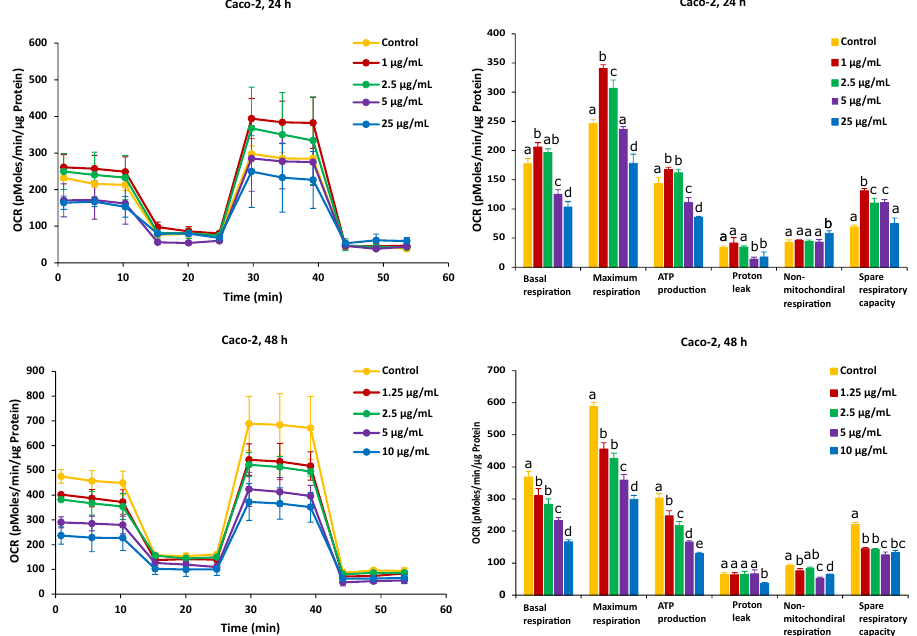
Figure 4. Effect of AFB1 on oxygen consumption rate (OCR) ( left ) and different mitochondrial parameters ( right ) in Caco-2 cells after 24 h and 48 h of exposure. Data (at least four technical replicates) are expressed as mean ± standard deviation. Mean values with different letters (a–e) within each mitochondrial parameter indicate significant differences ( p < 0.05) among different AFB1 treatments according to one way ANOVA test followed by Tukey HSD multiple-comparison test as a post hoc